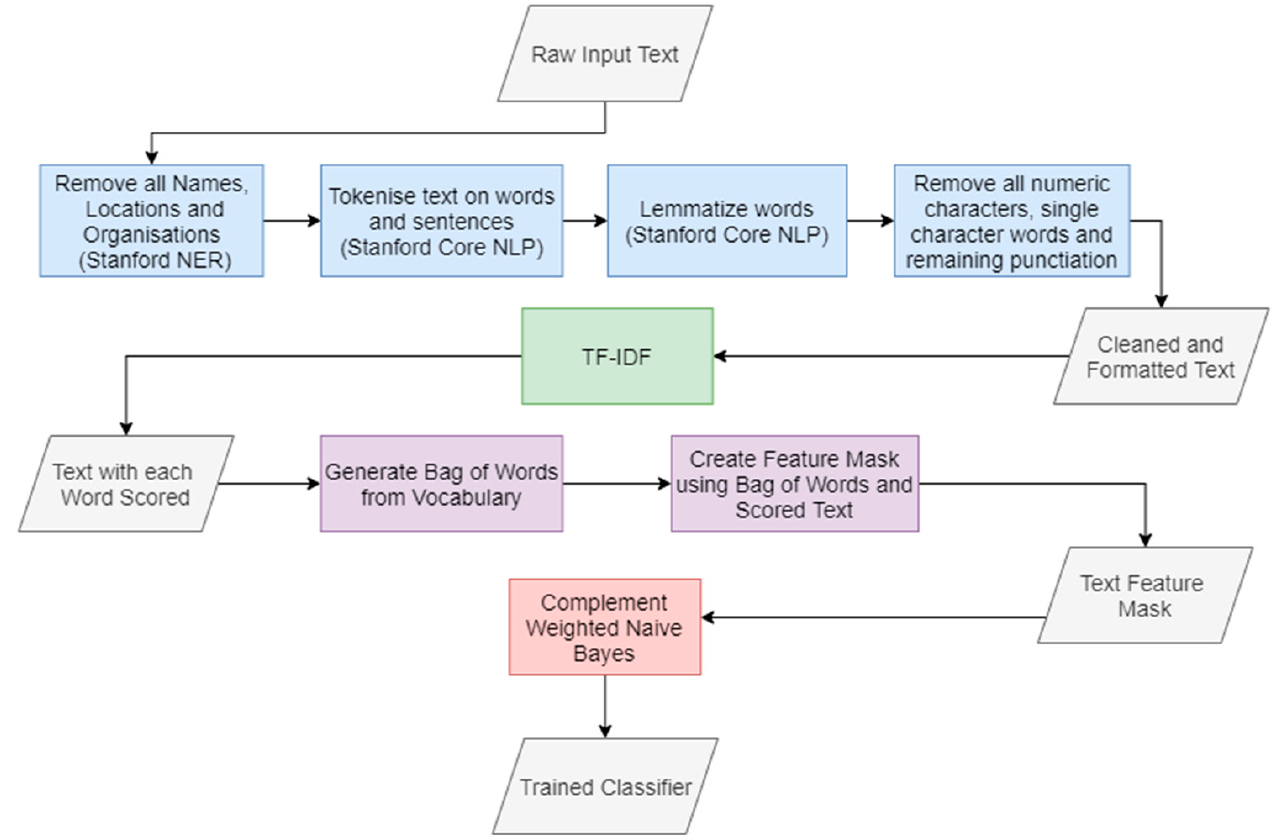
Figure 4. Representation of the processing pipeline used for hyper parameter tuning. From the text input all the way through the processes of tokenizing, lemmatizing, additional text cleaning, TF- IDF scoring, BoW modeling, creation of feature masks to the final stage of using the complement weighted naïve bayes classifier.